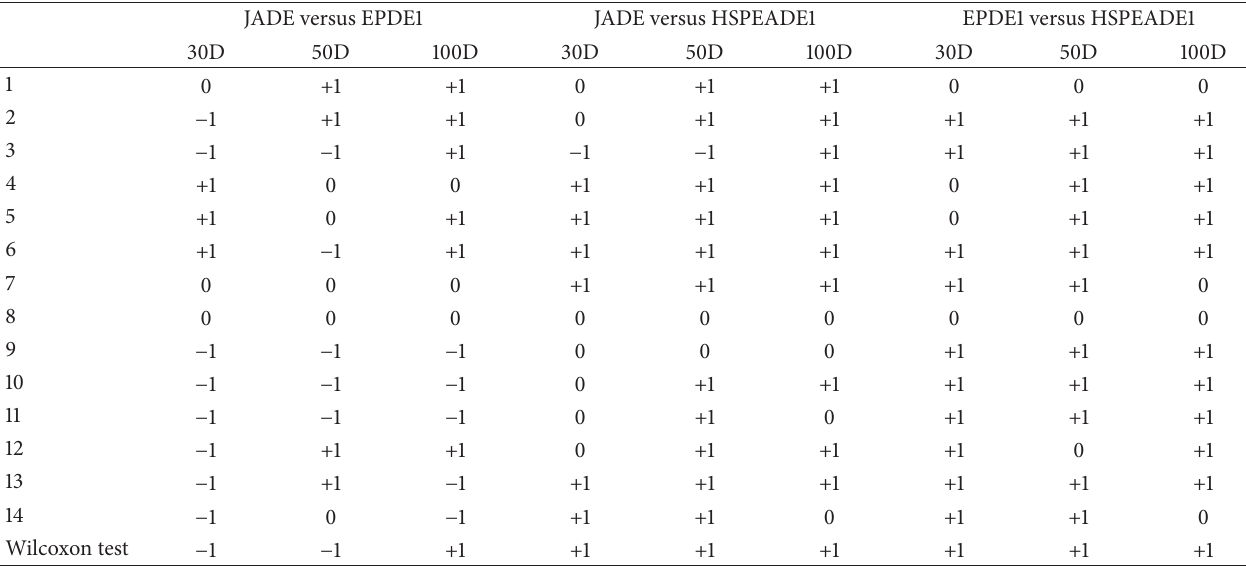
Table 7: Statistical test results to compare the performance of JADE, EPDE1, and HSEPDE1.